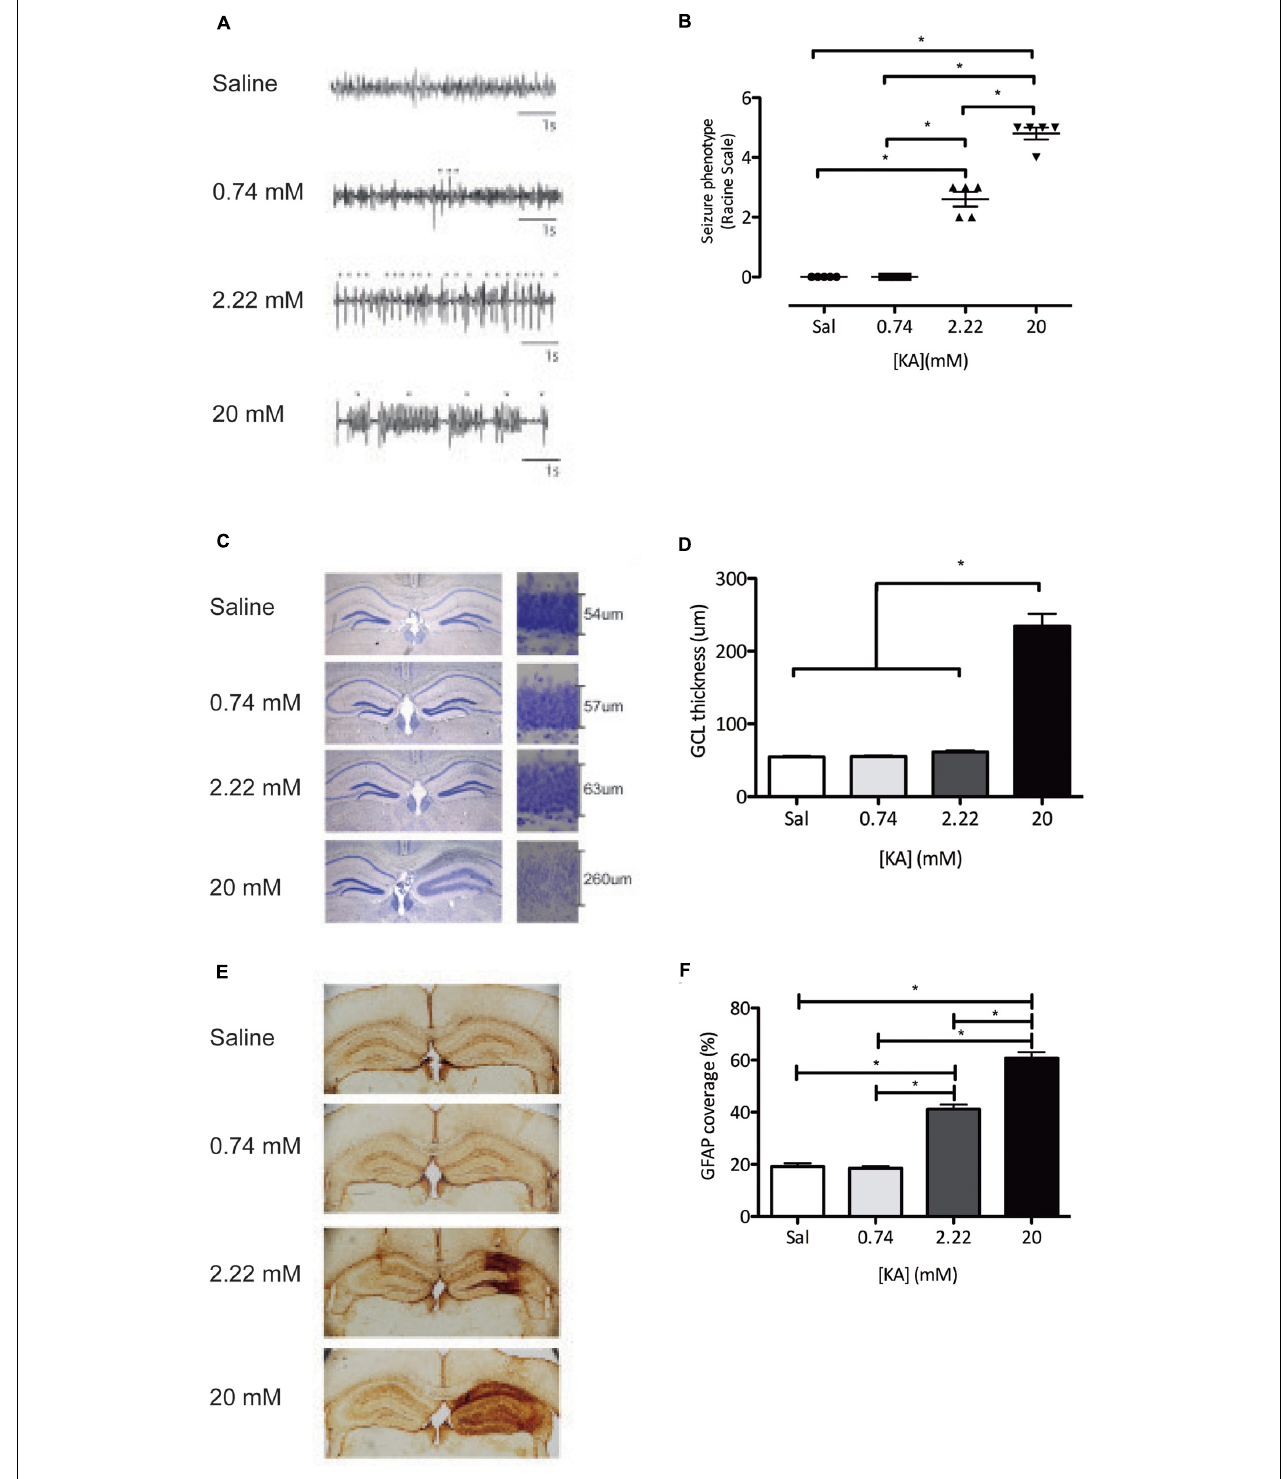
FIGURE 1 | Characterization of the intrahippocampal dose-dependent KA model. (A) EEG recordings during the first 4 h of status epilepticus show clear divergent patterns dependent on the KA dose, varying from single spikes( ∗ ) (0.74 mM) and repetitive single spikes (2.22 mM), to repetitive spike-bursts ( ∇ ) (20 mM). (B) Classification of behavioral seizures during the first 4 h of status epilepticus assessed using the Racine scale. (C) A Nissl staining shows dispersion of the granule cell layer. (D) Quantification of the granule dispersion 28 days after KA administration. (E) Immunohistochemistry against GFAP reveals KA dose-dependent induction of astrogliosis. (F) Quantification of GFAP coverage of the total hippocampus 28 days after KA administration. ∗ P < 0.05.